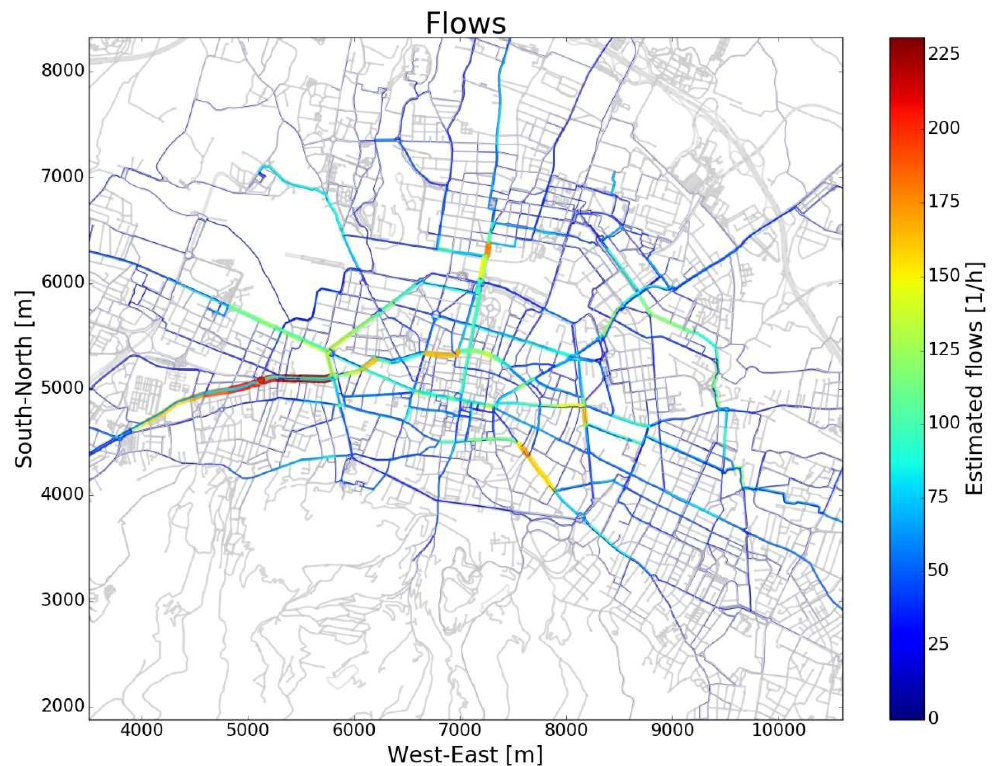
Figure 7. Estimated unidirectional bicycle flows in cyclists per hour during workday morning peak hours (from 8:30 to 10:30). Flows only on network links where GPS points have been detected.